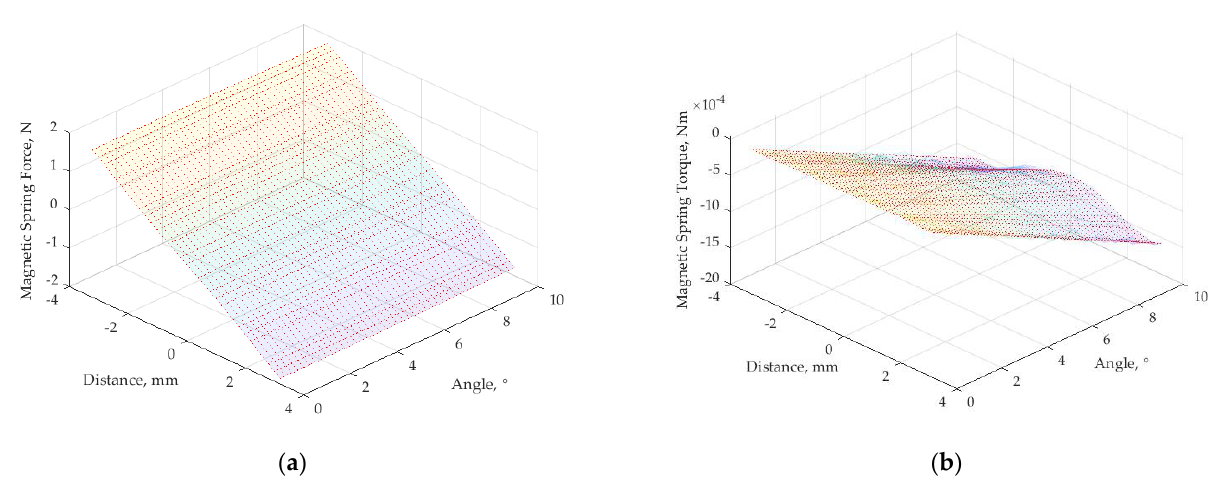
Figure 4. The force ( a ) and torque ( b ) as a function of the linear and rotational position of the levi- tated magnet. levitated